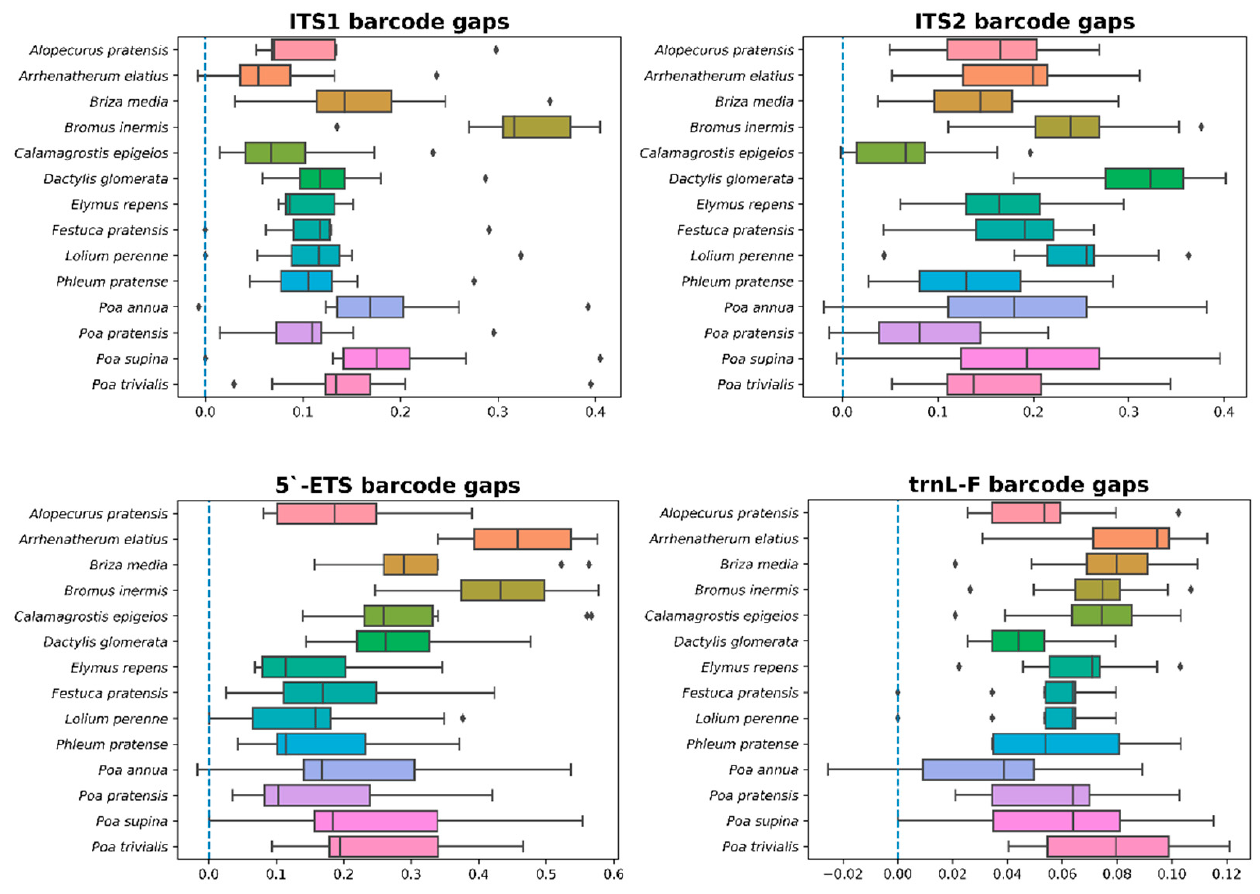
Figure 2. Barcoding gaps for all four DNA barcodes in the study per species.